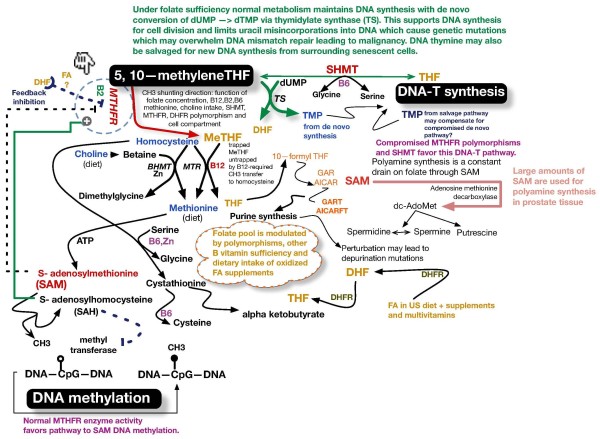
Metabolic interactions between folates and vitamins B12, B6, and B2. 677C → T thermolabile polymorphism with weakened interaction with B2 NAD cofactor disables MTHFR function by up to 70% in homozygotes. 15% of population is homozygous (2 inherited genes) 50% is heterozygous (one inherited gene). In the presence of this mutation (677C → T) when folate is plentiful this pathway provides adequate SAM for DNA methylation maintenance and shunts more 5,10 methylene THF to support DNA synthesis with less Uracil misincorporation into DNA with less 50% decreased incidence of colon cancer and acute lymphocytic leukaemia. However, in the presence of the mutation, if folate is low, then SAM DNA methylation may increase OR decrease and de novo DNA thymidine synthesis may decrease. There is disruption of normal intracellular methylated folate forms and all or some of these perturbations favour increased incidence of colon, breast, gastric, cervical and prostate cancer. Under most circumstances DNA synthesis through dTMP generation takes precedence over SAM DNA methlyation. Serine Hydroxymethyltransferase (SHMT) recently found to shift folate metabolism in the direction favoring de novo dTMP - DNA synthesis. B2 found to modulate (lessen) effects of MTHFR polymorphisms. Diet and all B vitamin levels modulate various folate pathways and therefore risks for malignancy!. Newly noted polymorphisms of DHFR (rs1677693 & rs1643659) have 30% decreased risk while MTR polymorphism (rs4659744) has 25% decreased risk of colon cancer only in the absence of FA supplements or FA supplemented diet. Changes in B vitamin concentrations and enzyme polymorphisms may produce unpredictable DNA methylation changes in part by varying DNA methyl transferase concentrations and SAM/SAH concentrations i.e. folate depletion may cause global DNA hypomethylation and specific CpG hypermethylations.